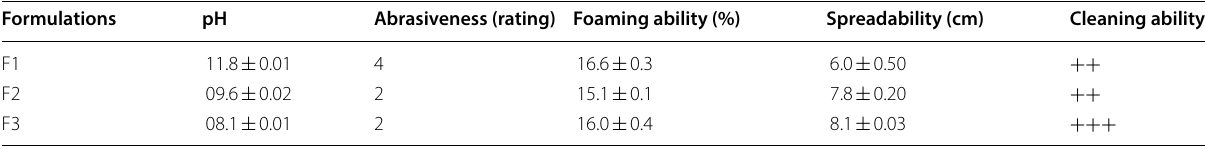
Table 3 Physico-chemical properties of tooth paste formulations Formulations